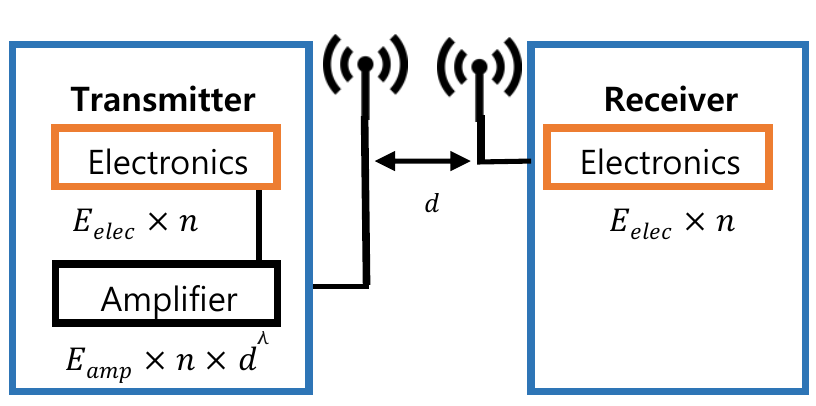
Figure 3. First-order radio model for energy consumption